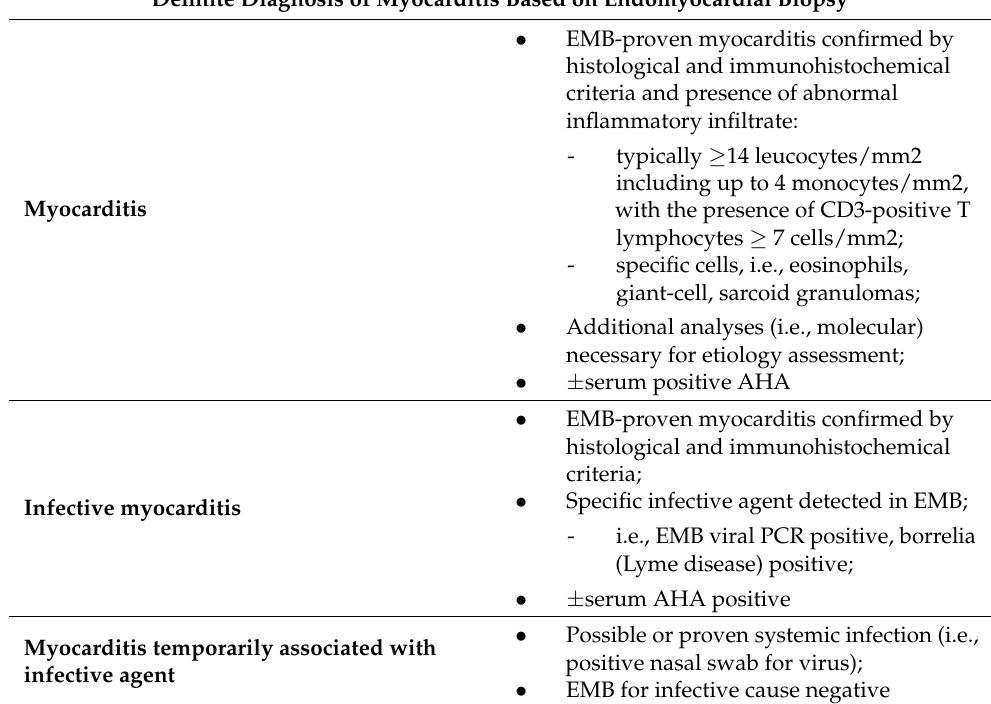
Table 1. Important definitions required for accurate diagnosis of